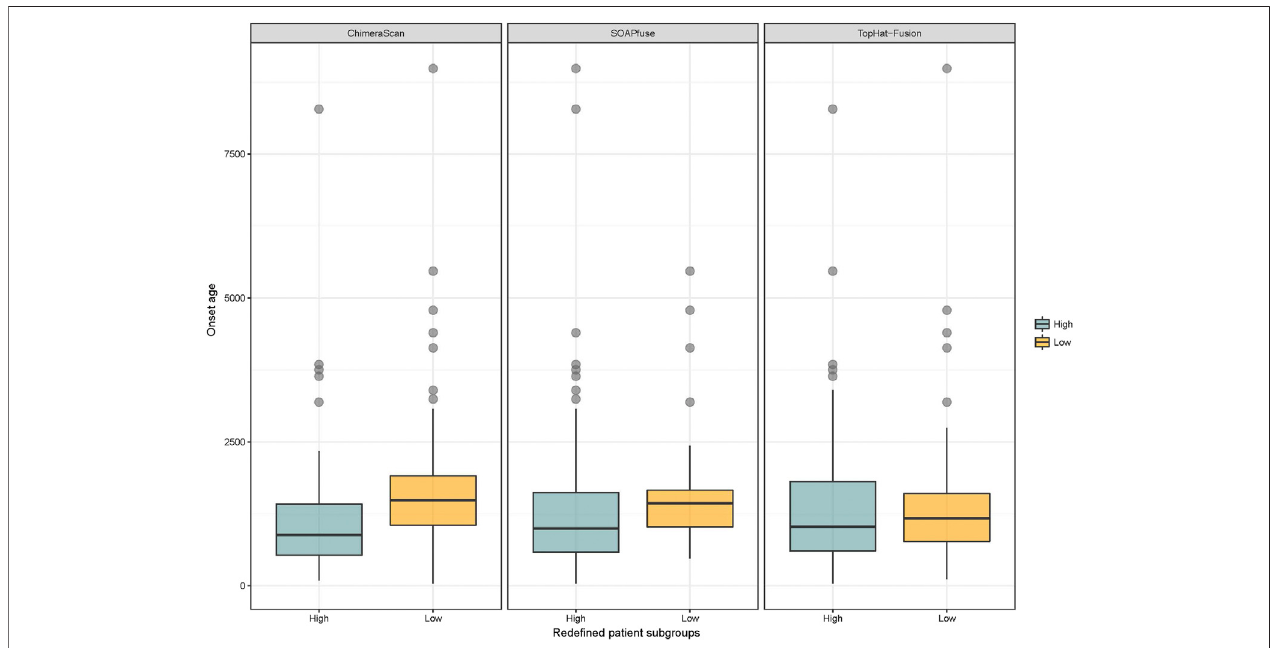
FIGURE 6 | Distribution of onset age in the rede fi ned high-risk and low-risk NB patients: blue and yellow colors represent the rede fi ned high-risk and low-risk patient subgroups, respectively. The student ’ s t-test was used to generated p value.